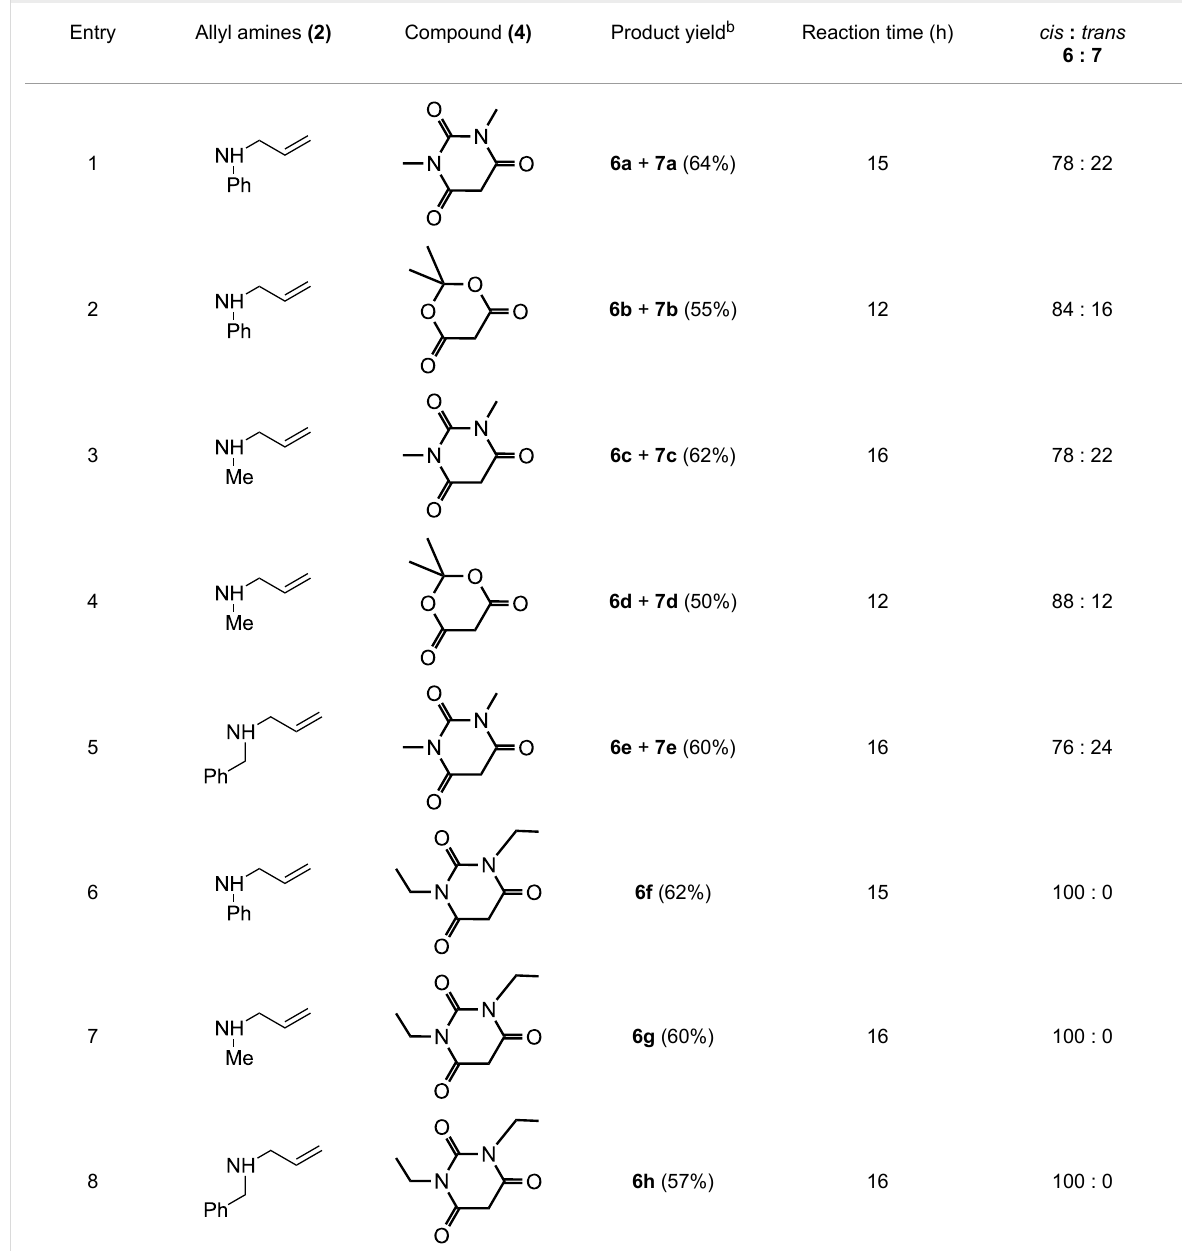
Table 1: Synthesis of some novel annulated pyrido[2,3- d ]pyrimidines 6 / 7 .